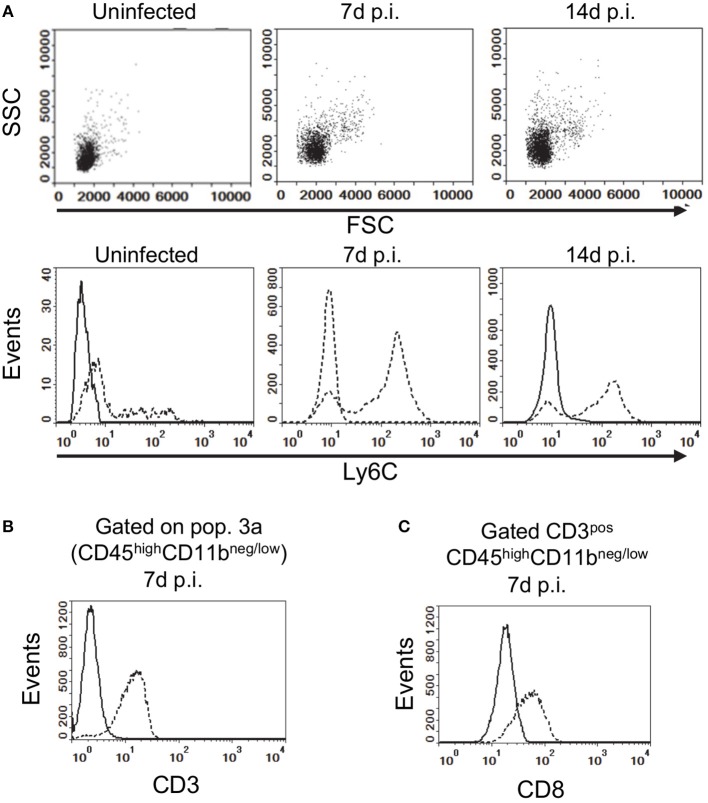
Gating strategy for analysis of brain leukocytes. (A) Gated CD45highCD11bneg/low leukocytes from uninfected, and infected mice 7 d and 14 d p.i. projected as dotplots (upper panels) showing FCS vs. SSC, and histograms (lower panels) showing Ly6C expression. Histograms (B,C) show expressions of CD3 on CD45highCD11bneg/low cells, and CD8a on gated CD3posCD45highCD11bneg/low cells (dotted lines), respectively, at 7 d p.i compared with isotype control (solid line). Representative plots are shown. Values given are gated events as a percentage of CD45pos cells.